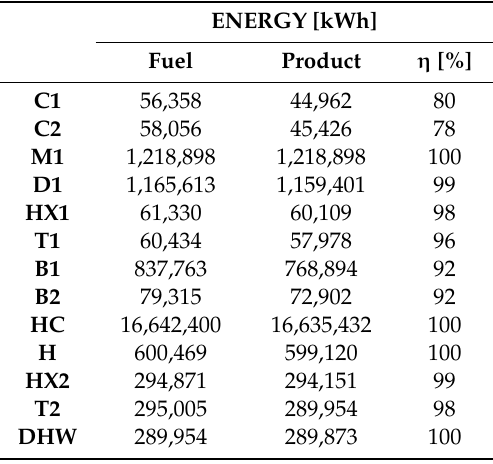
Table 2. Seasonal energy e ffi ciency of